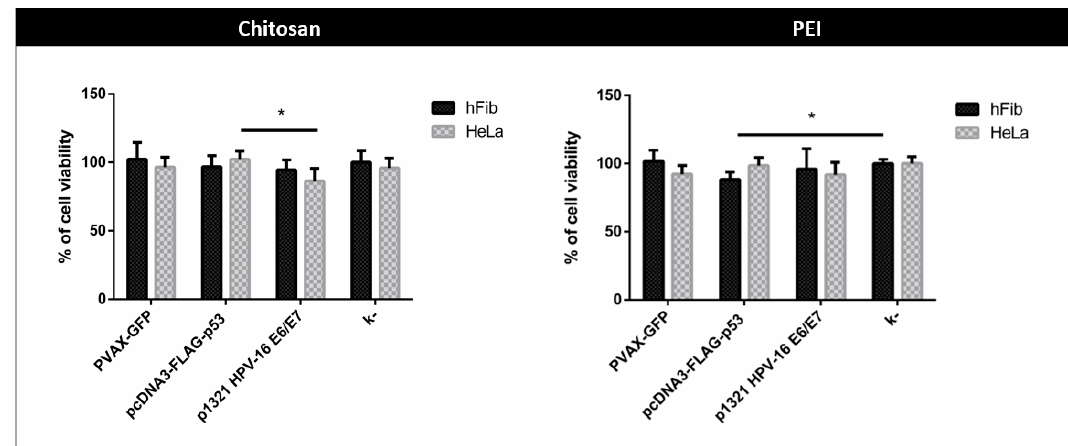
Figure 4. Evaluation of cell viability following transfection with CH and PEI polyplexes loaded with PVAX-GFP, pcDNA3- FLAG-p53 and the p1321 HPV-16 E6/E7 in different cell lines (human dermal fibroblasts (hFib) and HeLa cervix carcinoma), at 48 h after transfection. Data are represented as mean ± S.D., n = 3.